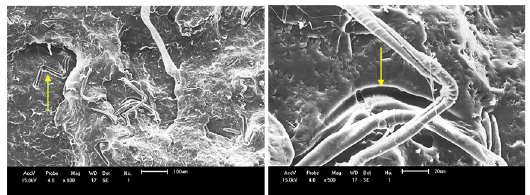
Mechanical properties in flexion for PCL and its